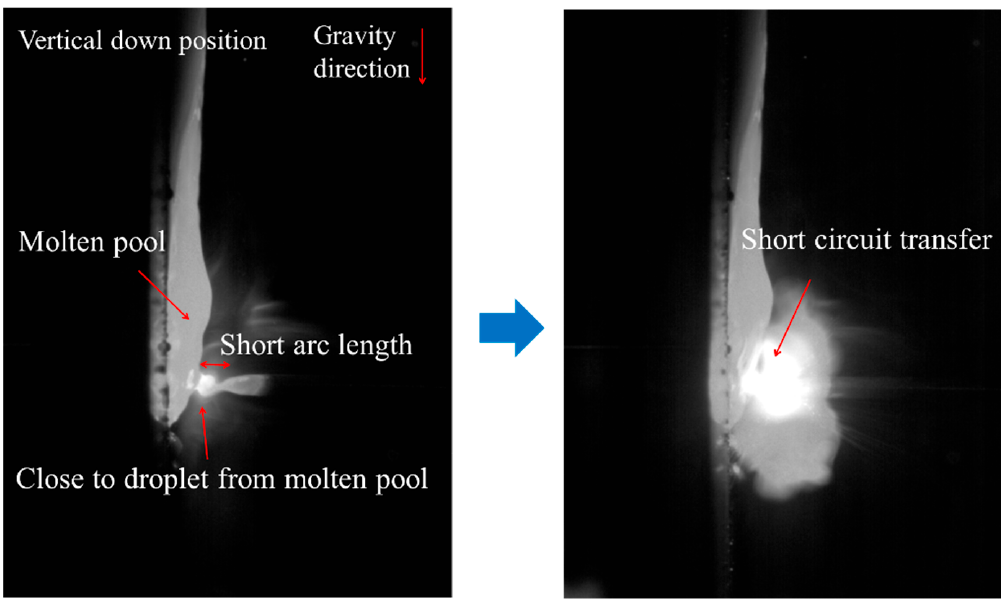
Figure 9. Cushion e ff ect in vertical down position. Figure 9. Cushion effect in vertical down position. Figure 9. Cushion effect in vertical down position.